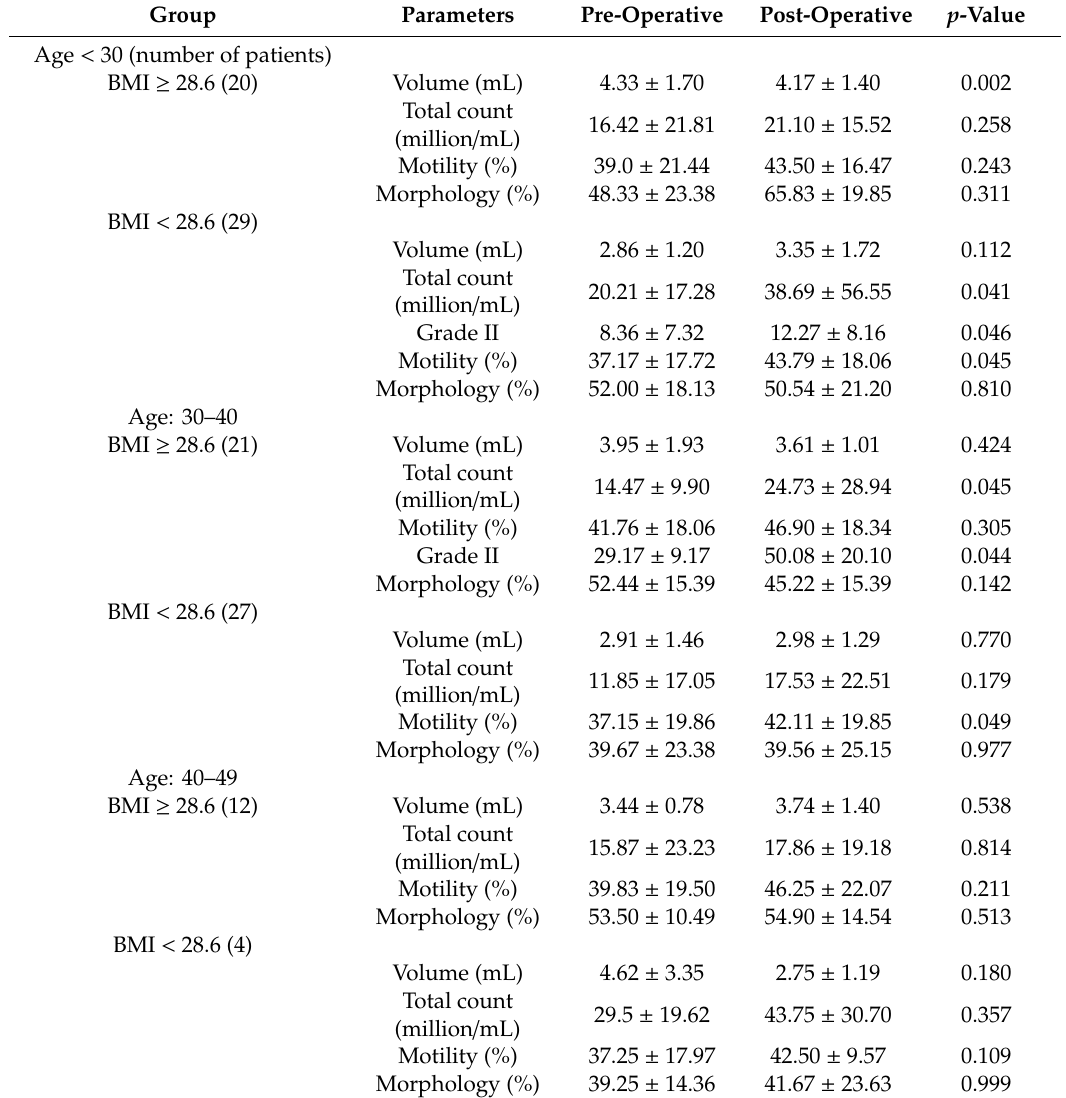
Table 5. Semen parameters pre- and post-varicocelectomy according to age and BMI. Group Parameters